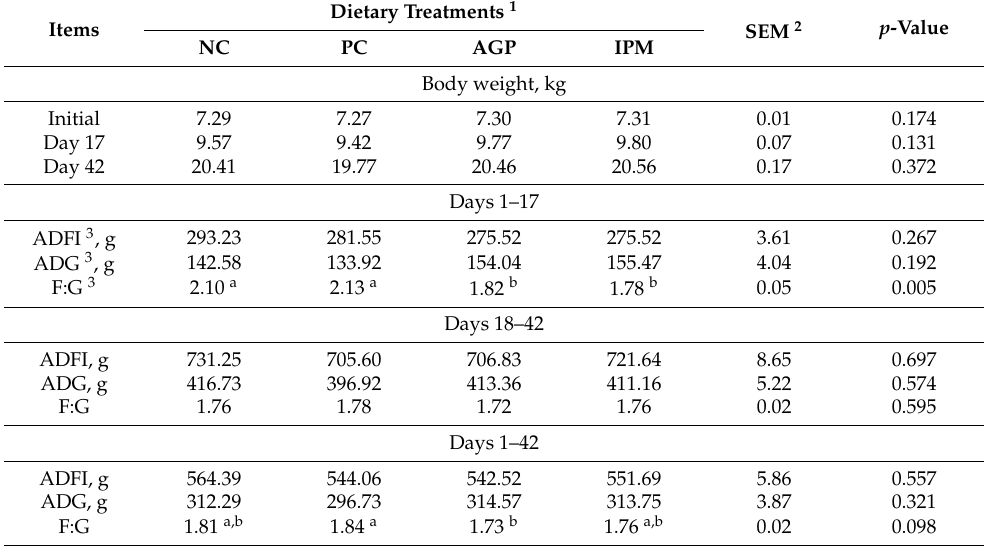
Table 2. Effect of dietary treatments on the growth performance of weaned pigs challenged with E. coli